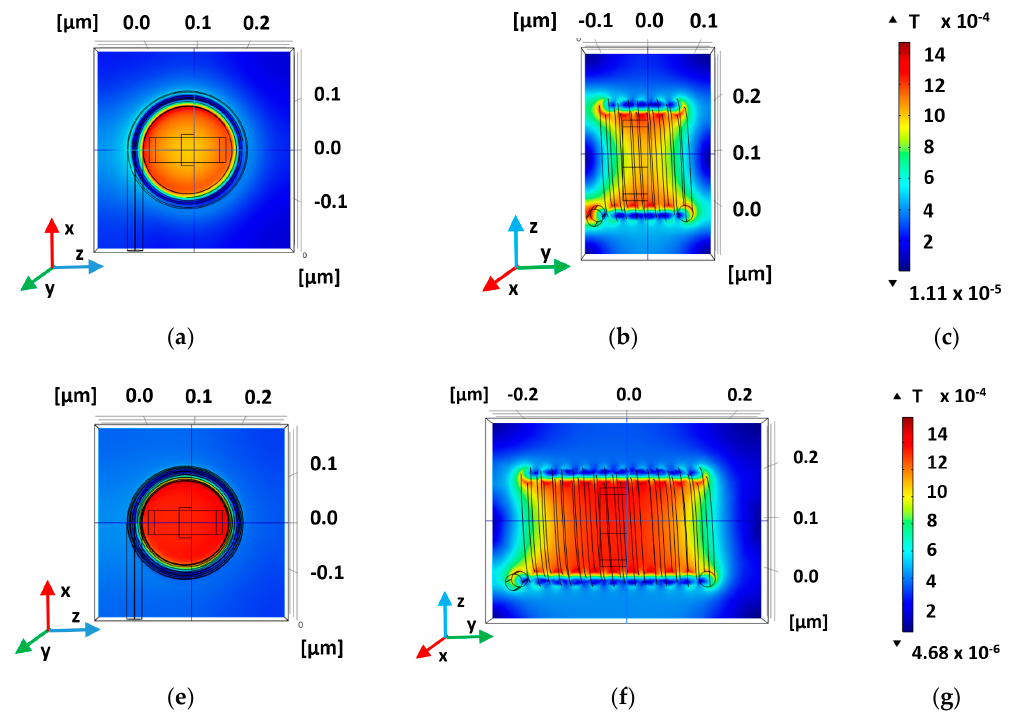
Figure 6. Magnetic flux density Norm (T), produced by a 15 nm copper coil with a number of loops, and an input electric current of 30 µA. ( a ) Face-view, five loops; ( b ) cross-view, five loops; ( c ) scale, five loops; ( d ) face-view, ten loops; ( e ) cross-view, ten loops; ( f ) scale, ten loops.